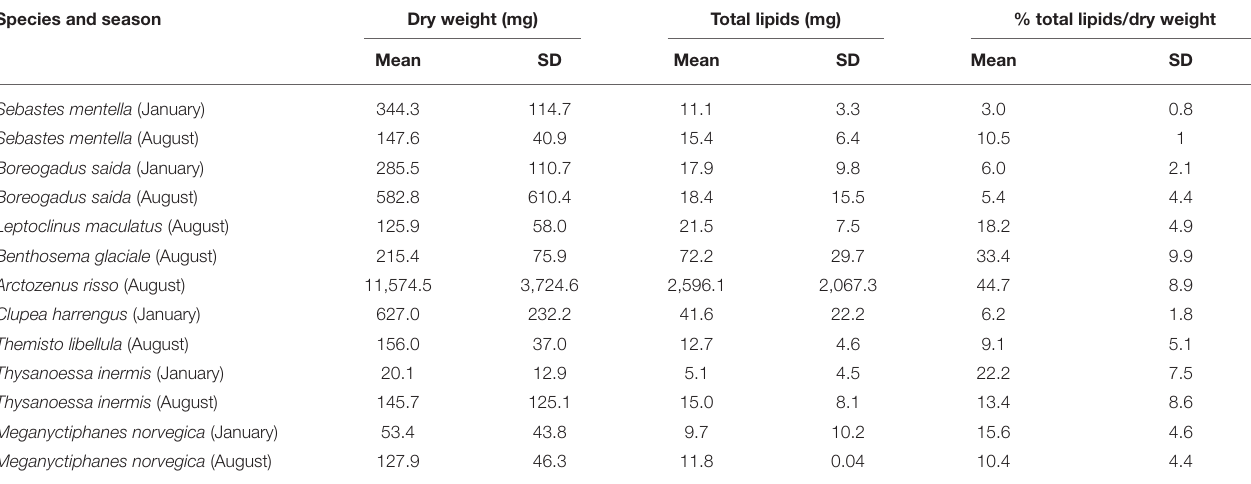
TABLE 3 | Mean dry weight, lipid weight and lipid/dry weight ratios with standard deviation (SD) for the most abundant fish and crustaceans. Species and